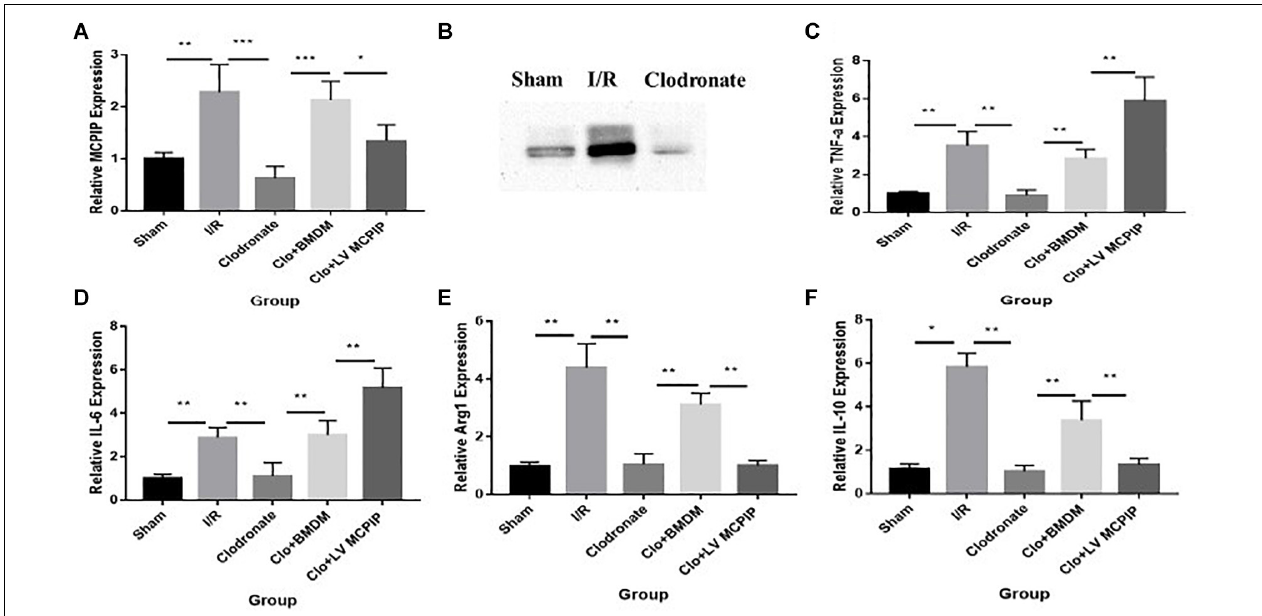
FIGURE 2 | Expression levels of MCPIP and macrophage M1 and M2 markers were evaluated for mice undergoing IR injury. (A) Gene expression levels of MCPIP by RT-PCR in all groups. (B) protein expression levels of MCPIP by Western blotting analysis in the Sham, I/R, and Clodronate groups. (C–F) gene expression levels of M1 (TNF-a and IL-6) and M2 (IL-10 and Arg1) markers by RT-PCR in all groups. * P < 0.05, ** P < 0.01, and *** P <